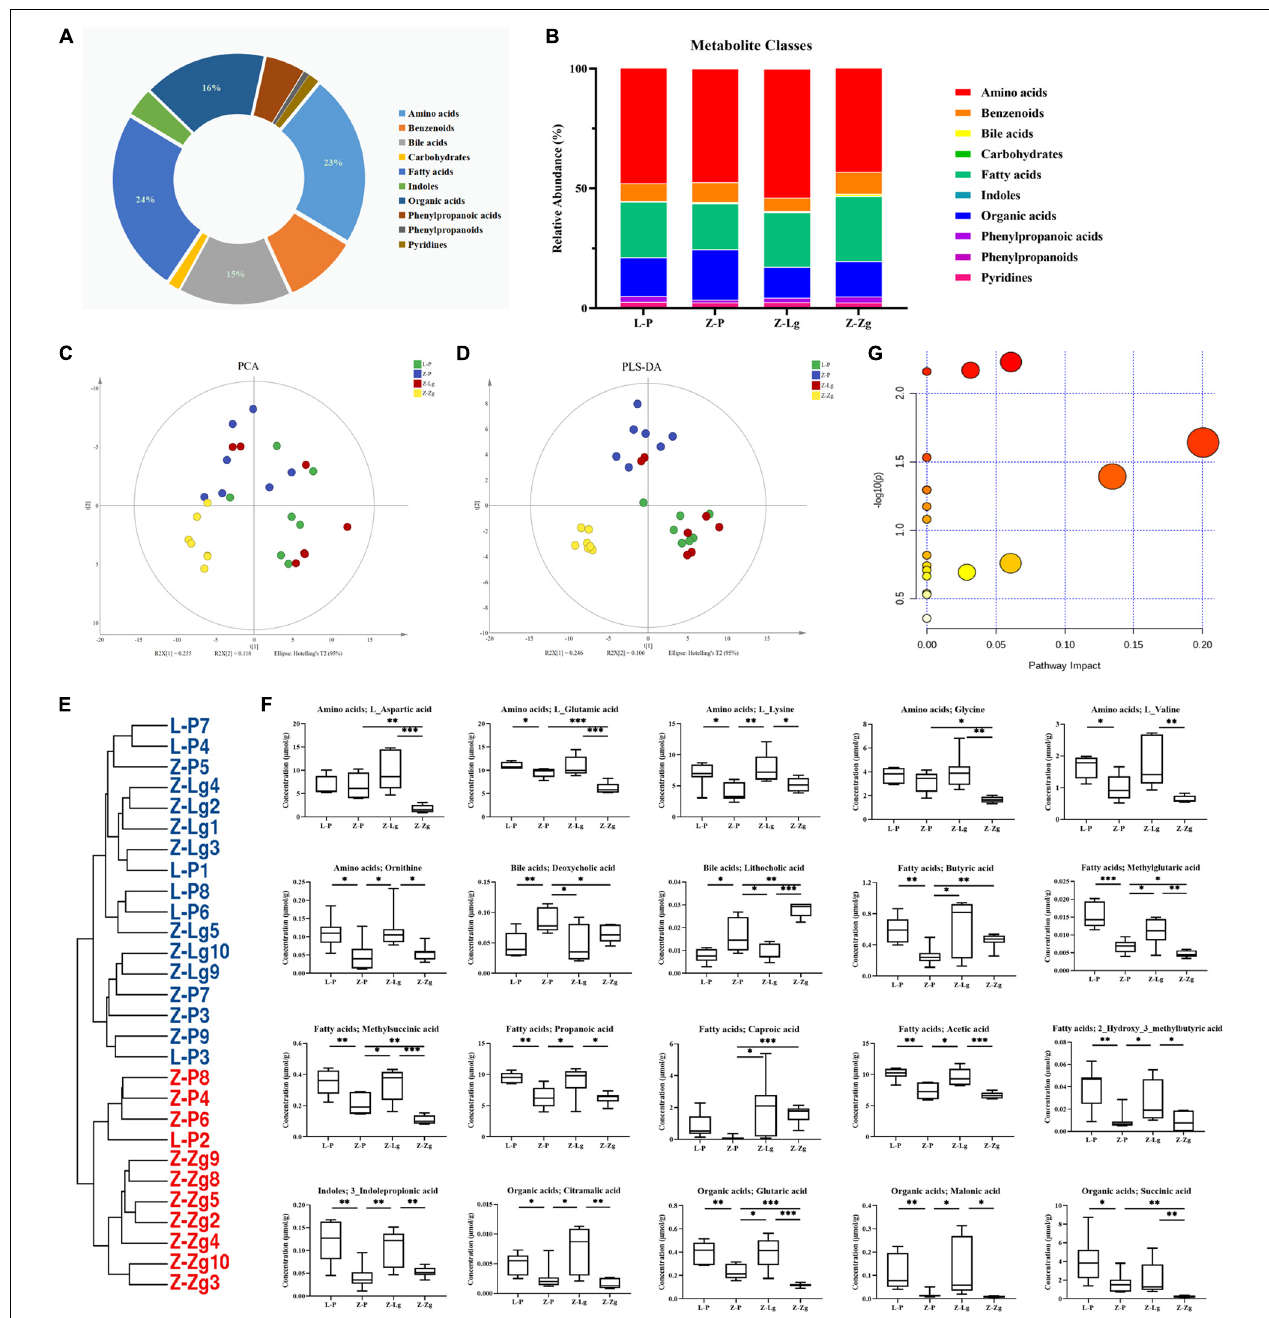
FIGURE 7 | GMT changes metabolite composition of gut microbiota in ZDF recipient rats. (A,B) Composition of metabolite classes analysis. (C,D) Global metabolite analysis based on PCA and PLS-DA score plots. (E) Phylogenetic tree map of the metabolites. (F) Differential metabolites [L_aspartic acid: F ( 3 , 20 ) = 9.366, P = 0.0005; L_glutamic acid: F ( 3 , 18 ) = 16.26, P < 0.0001; L_lysine: F ( 3 , 22 ) = 5.884, P = 0.0042; glycine: F ( 3 , 20 ) = 8.070, P = 0.0010; L_valine: F ( 3 , 20 ) = 6.989, P = 0.0021; ornithine: F ( 3 , 24 ) = 5.983, P = 0.0034; deoxycholic acid: F ( 3 , 24 ) = 5.075, P = 0.0073; lithocholic acid: F ( 3 , 22 ) = 28.50, P < 0.0001; butyric acid: F ( 3 , 24 ) = 4.146, P = 0.0168; methylglutaric acid: F ( 3 , 24 ) = 20.94, P < 0.0001; methylsuccinic acid: F ( 3 , 22 ) = 16.14, P < 0.0001; propionic acid: F ( 3 , 24 ) = 8.244, P = 0.0006; caproic acid: F ( 3 , 21 ) = 3.217, P = 0.0436; acetic acid: F ( 3 , 22 ) = 16.67, P < 0.0001; 2-hydroxy-3-methylbutane acid: F ( 3 , 24 ) = 7.715, P = 0.0009; 3-indolepropionic acid: F ( 3 , 24 ) = 10.24, P = 0.0002; citramalic acid: F ( 3 , 24 ) = 7.506, P = 0.0010; glutaric acid: F ( 3 , 22 ) = 17.92, P < 0.0001; malonic acid: F ( 3 , 24 ) = 5.205, P = 0.0065; succinic acid: F ( 3 , 23 ) = 6.524, P = 0.0024]. (G) Diagram of the metabolic enrichment pathways. Data are shown as mean ± SD ( n = 5–7 per group). ∗ P < 0.05, ∗∗ P <0.01, ∗∗∗ P < 0.001. One-way or two-way ANOVA, followed by Tukey’s post-hoc test. PCA, principal component analysis; PLS-DA, partial least squares discriminant